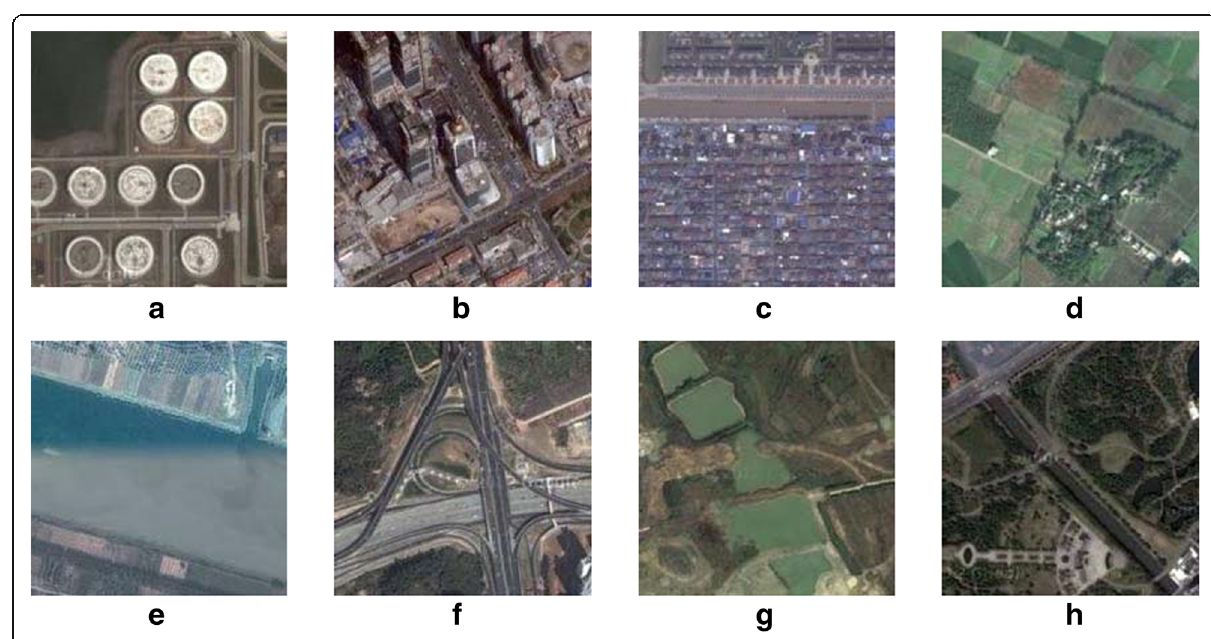
Fig. 3 Eight scene images from the SIRI-WHU dataset: a industrial, b commercial, c residential, d agriculture, e river, f overpass, g pond, and h park